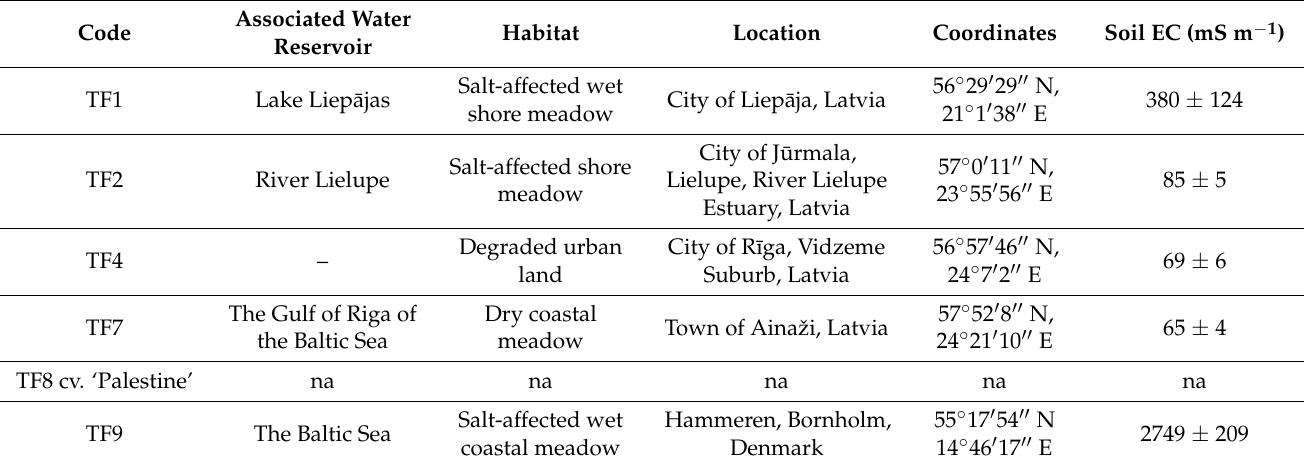
Table 2. Characterization, geographical location of accessions of Trifolium fragiferum used in the present study and soil electrical conductivity (EC) at the